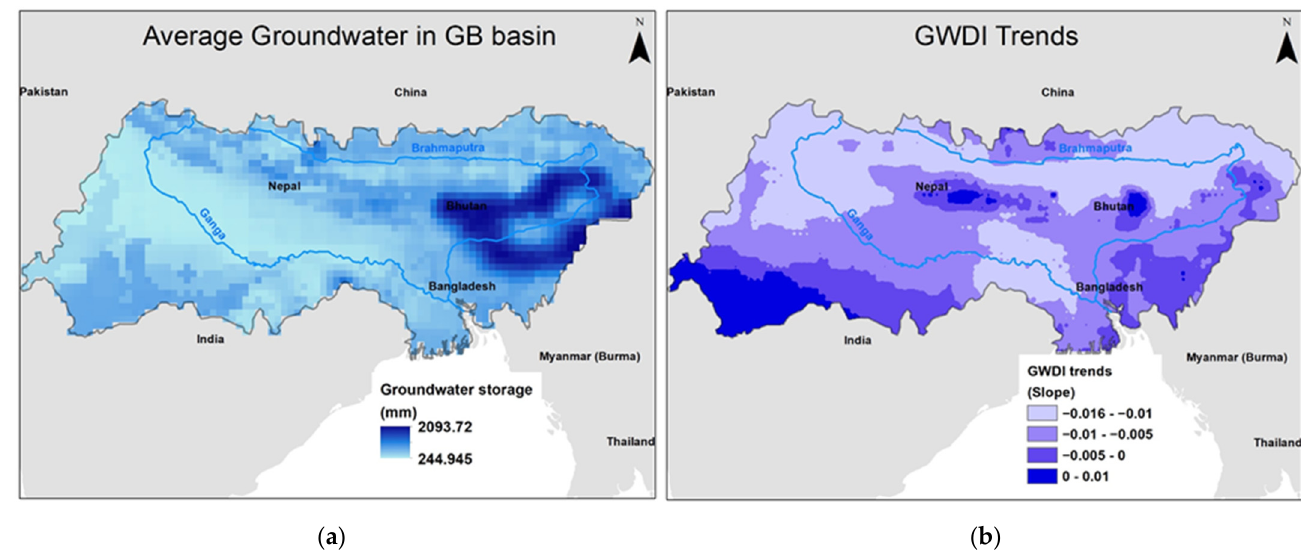
Figure 11. ( a ) Average groundwater and ( b ) GWDI trends in Ganga–Brahmaputra Basin. Principal components were extracted for SPIs at different time scales. Variance